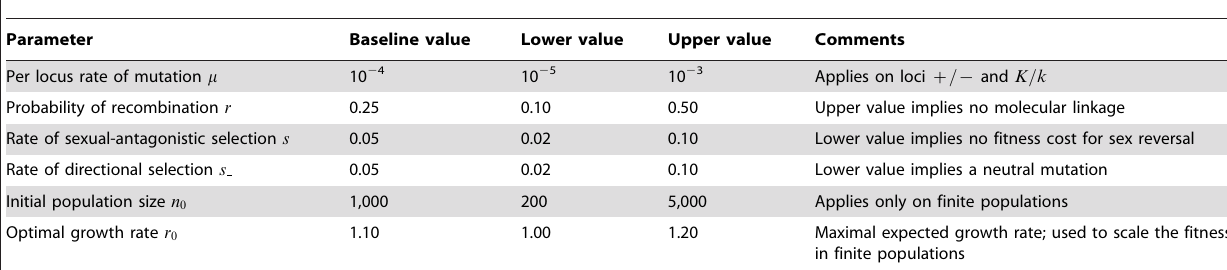
Table 1. Summary of model parameters.